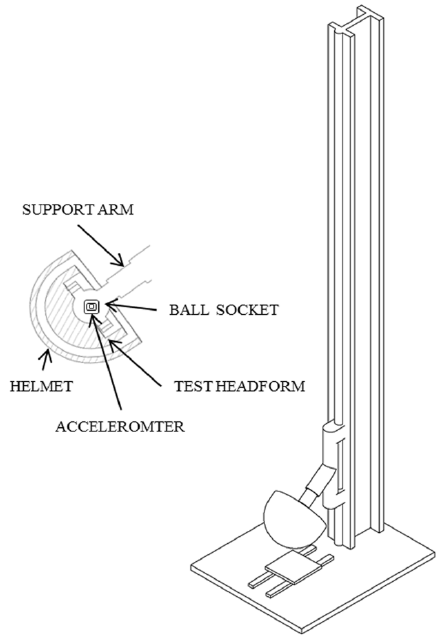
Figure 2. Experimental setup for free-fall impact tests.